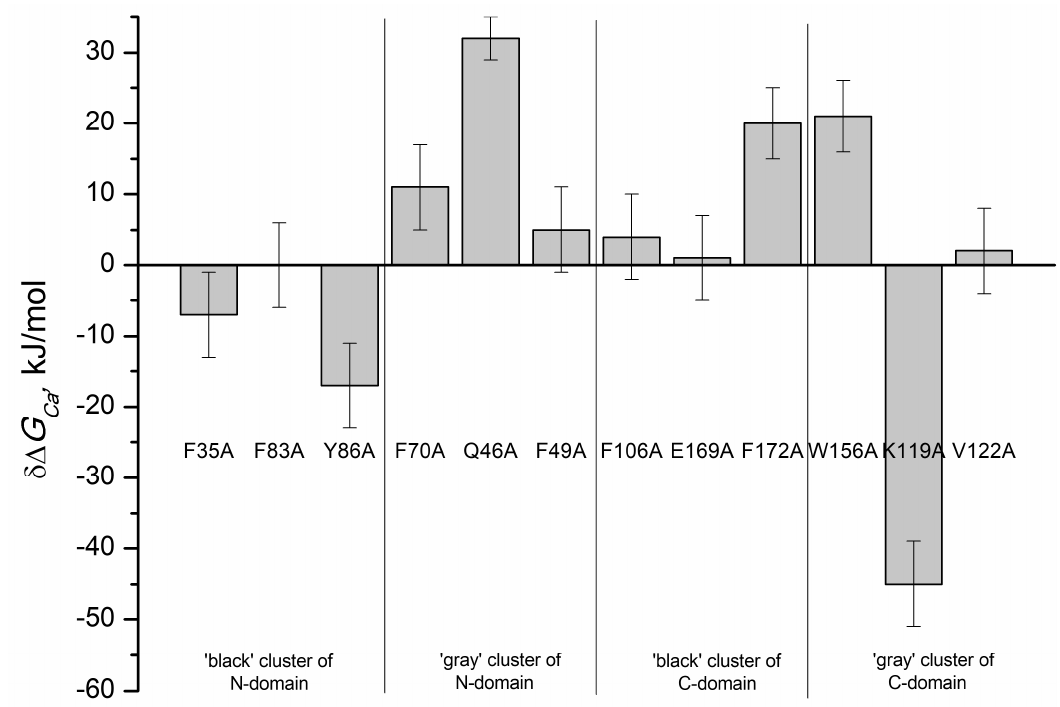
Figure 8. Effects of alanine substitutions in the ‘black’ and ‘gray’ clusters in rWT recoverin on the change of total free energy of protein induced by Ca 2 + binding, ∆ G Ca ( − RT ln ( K a,i • [H 2 O]) i = 1, 2) [26].